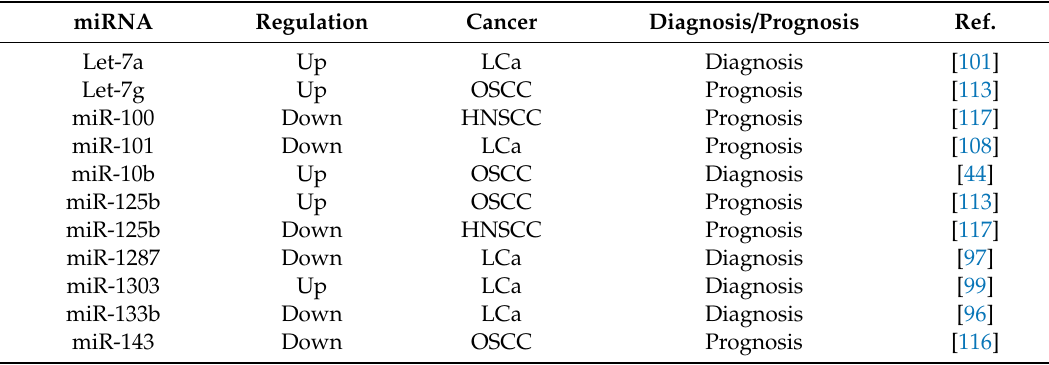
Table 2. Potential predictive and / or prognostic biomarker in